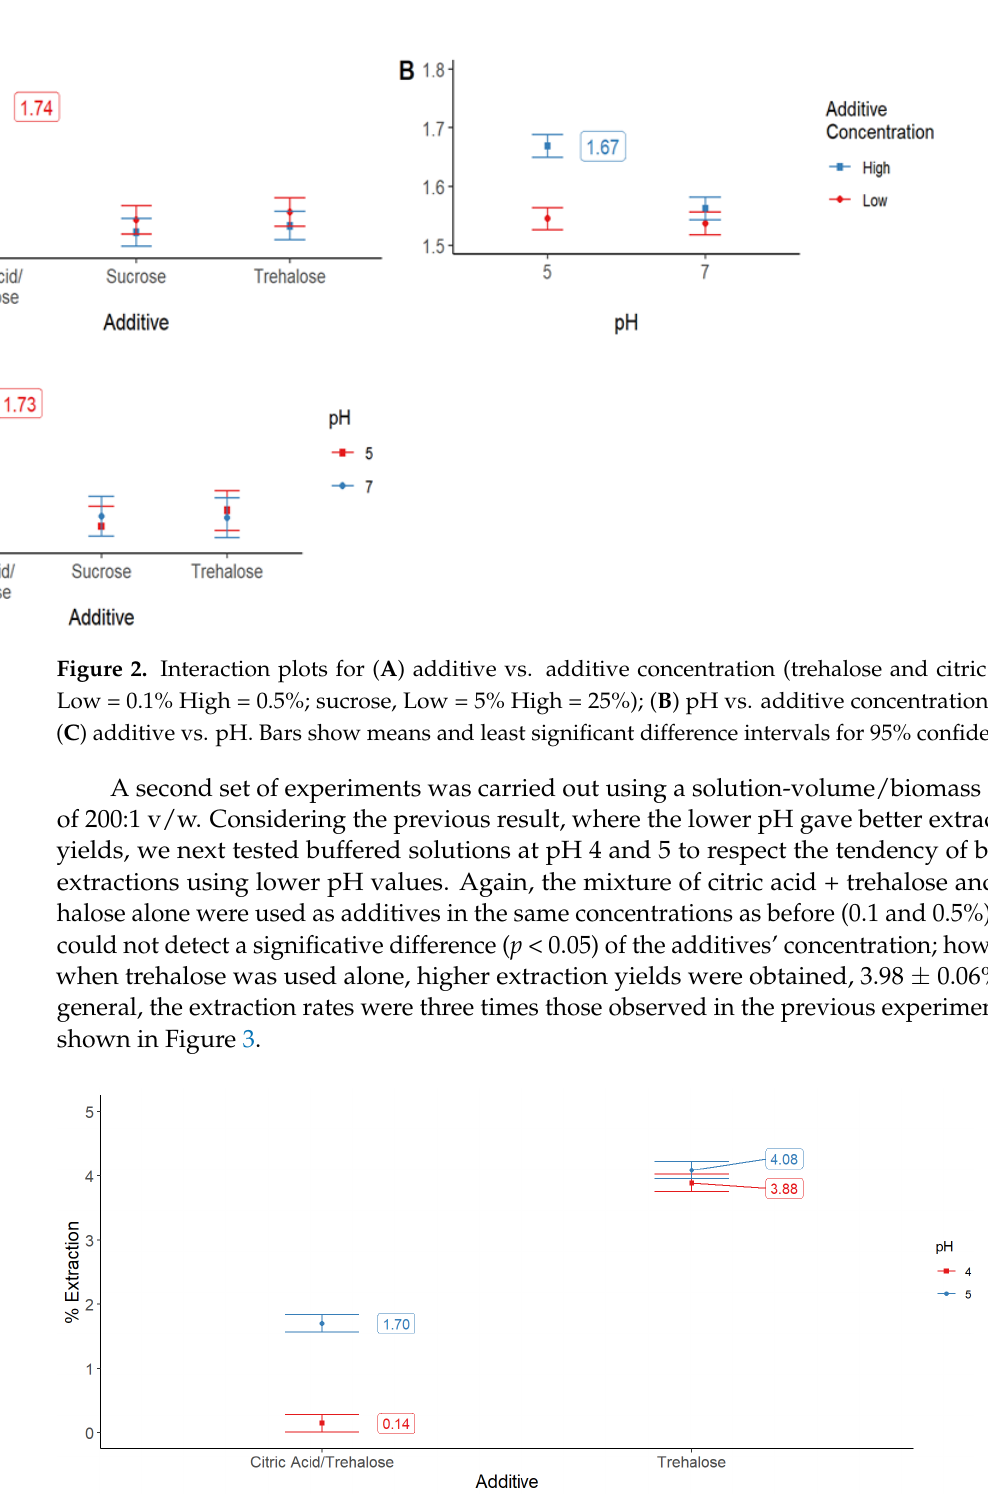
Figure 3. Interaction plot for additives and pH as extraction factors. All bars show the least significant difference intervals for 95% confidence.